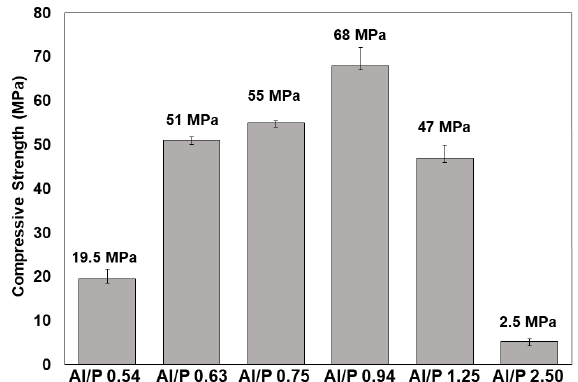
Figure 9. Evolution of the mechanical strength of studied MKPC mortars as a function of Al/P ratio. Mortars were cured for 1 day at room temperature, and post-cured at 60 ◦ C for another day. They were mechanically tested seven days after synthesis.